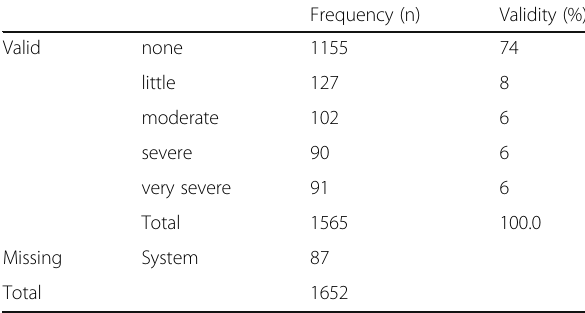
Table 1 Wish for further cosmetic surgery